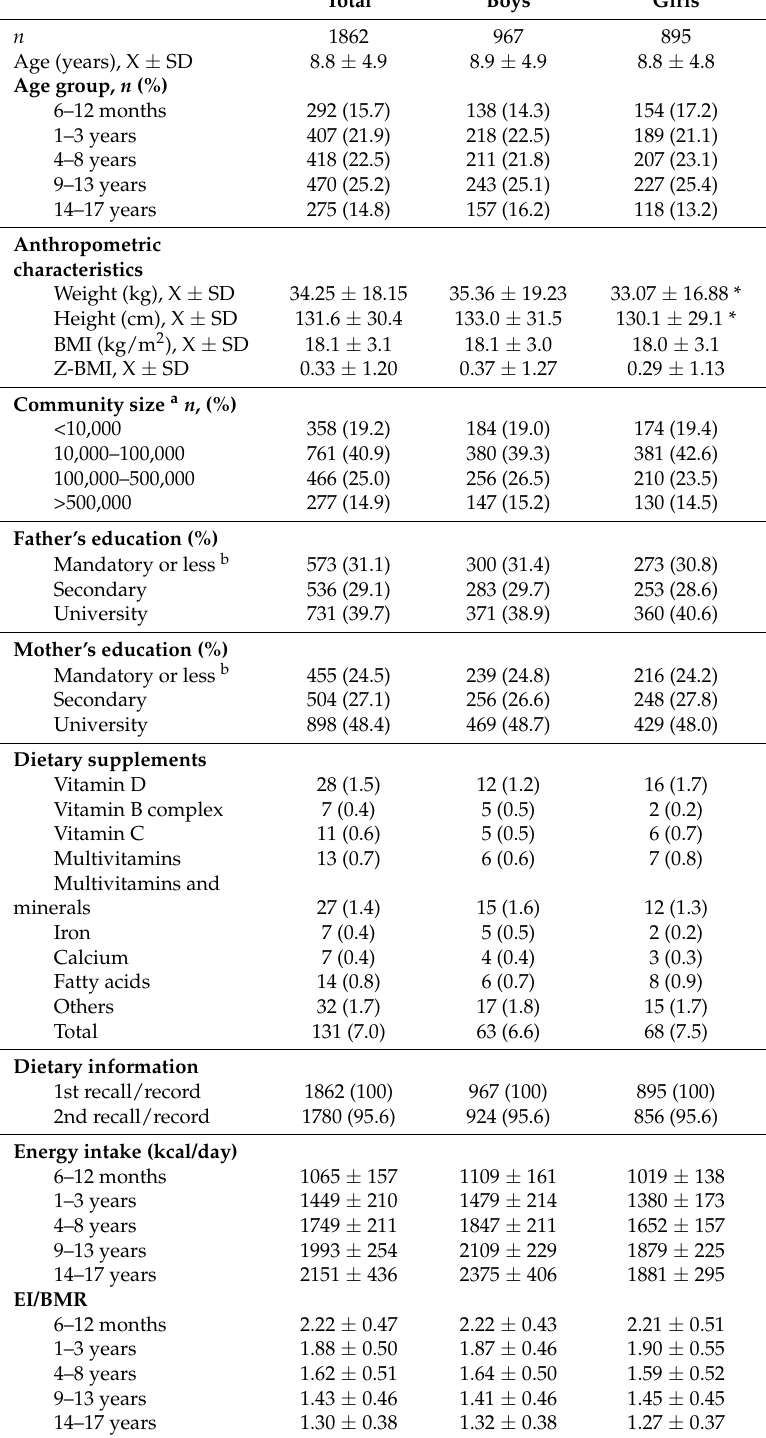
Table 1. Characteristics of the studied sample in the ENALIA